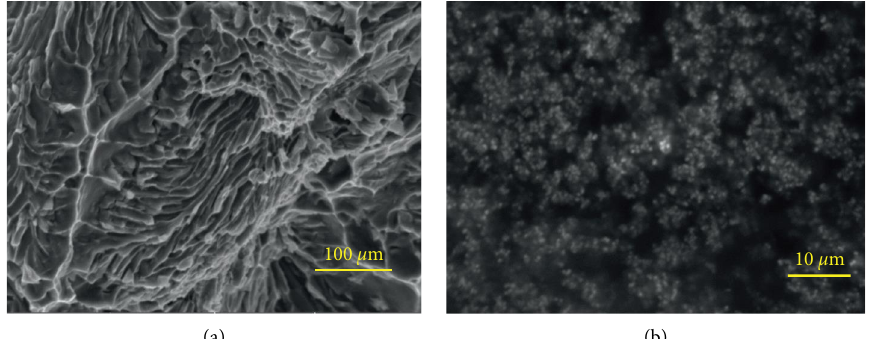
Figure 2: LM13 composite microstructure at tempered conditions: (a) sphere shape Silicon between and around the aluminum dendrites (b) High resolution image showing spherical eutectic shape Silicon